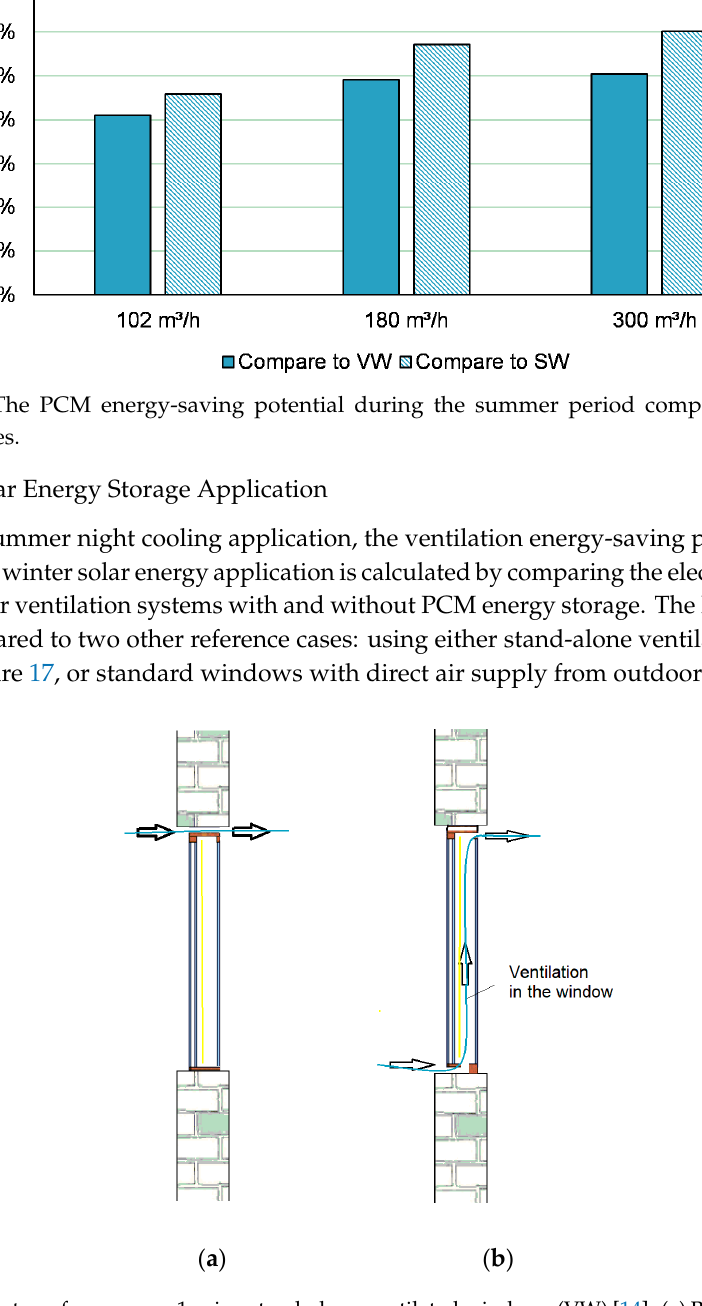
Figure 17. Winter reference case 1 using stand-alone ventilated windows (VW) [14]. ( a ) Bypass ventilation, when T indoor > 24 ◦ C. ( b ) Heat mode, when T indoor < 24 ◦